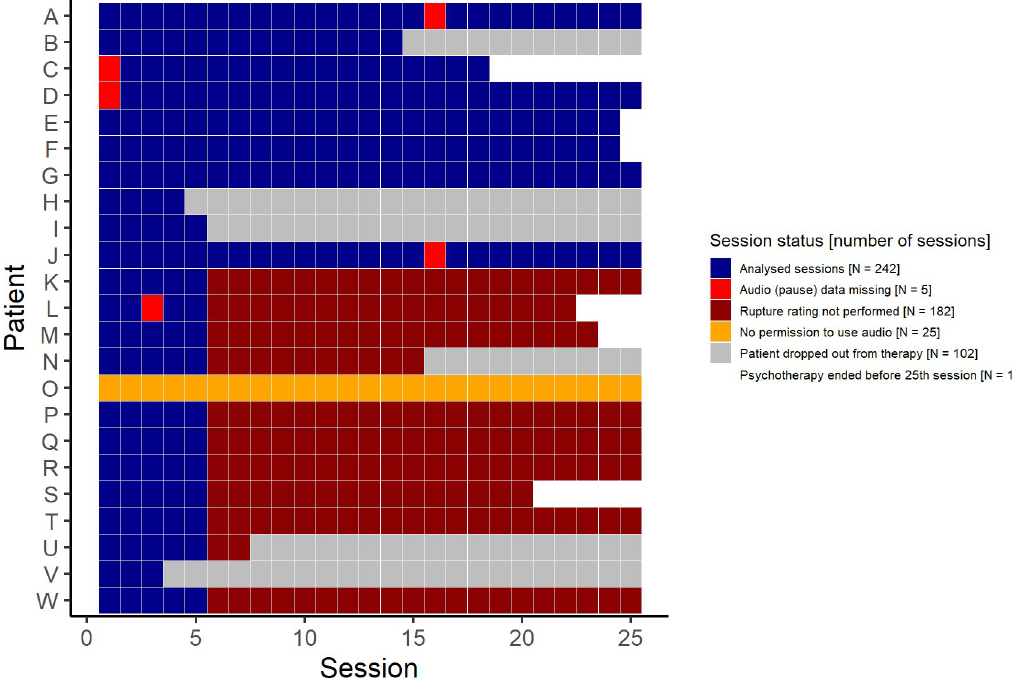
Fig 1. Analysed sessions and missing